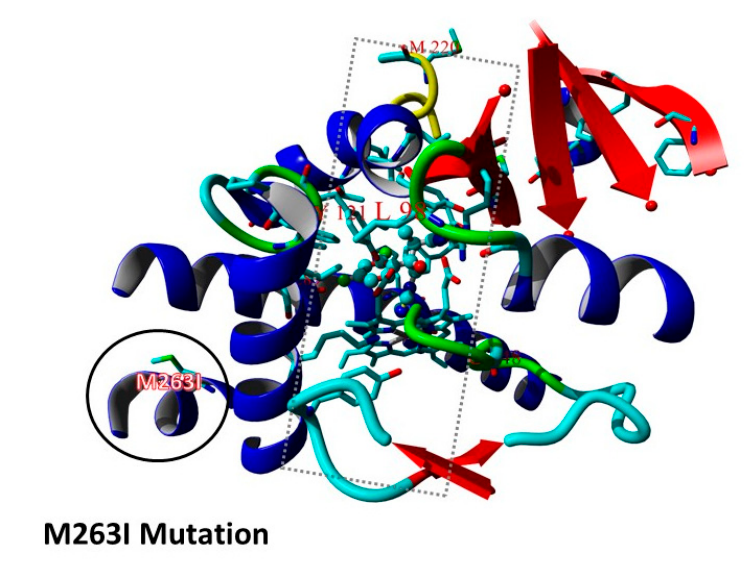
Figure 3. Representative schematic of the M263I mutation in the Aspergillus fumigatus Cyp51A homology protein model. Predicted location of the M263I cyp51A gene mutation in an optimized static Aspergillus fumigatus Cyp51A molecular docking and molecular dynamics homology protein model (MM / MD) of Aspergillus fumigatus . Rectangle (dotted) contains the predicted triazole antifungals binding region and commonly associated region of known resistance mutations. Circle (plain) contains the predicted location of mutation M263I.